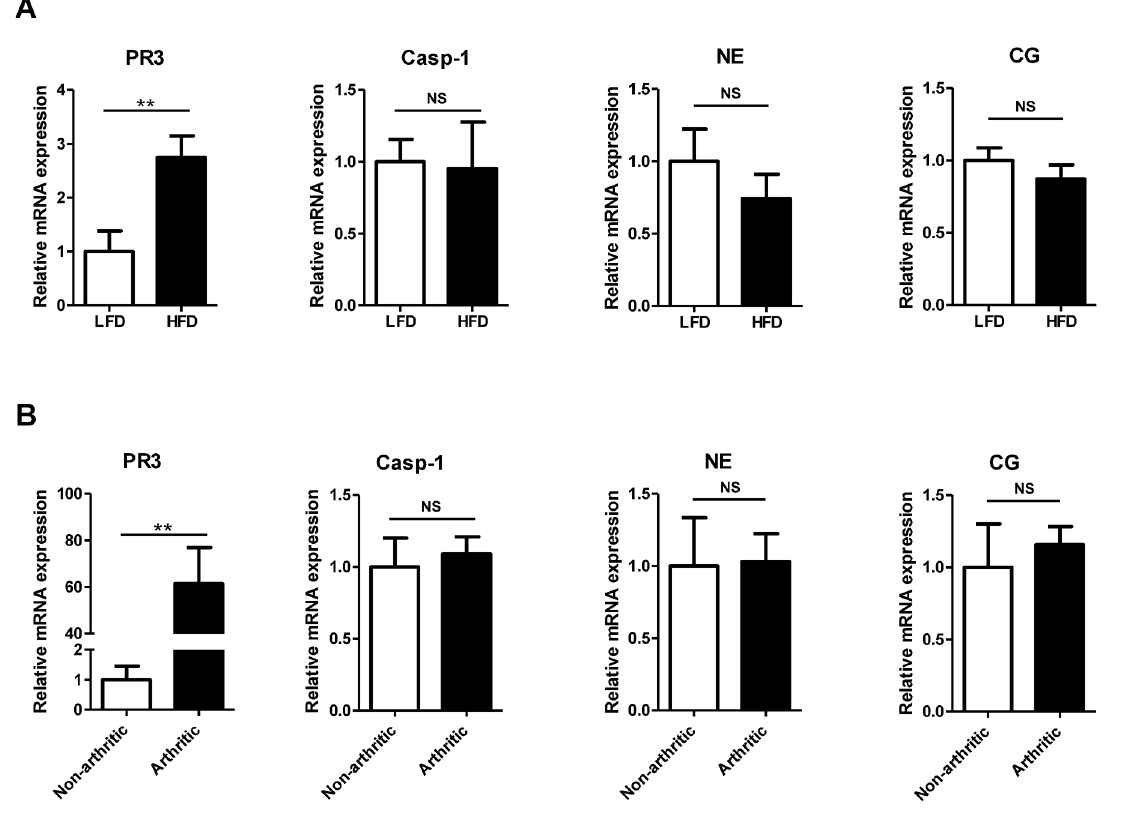
Figure 2. Relative mRNA expression of proteinase 3, caspase-1, neutrophil elastase and cathepsin G in liver. (A) Relative mRNA expres- sion of proteinase 3, caspase-1, neutrophil elastase and cathepsin G after 4 wks of diet intervention. (B) Relative mRNA expression of proteinase 3, caspase-1, neutrophil elastase and cathepsin G in nonarthritic and arthritic mice. PR3, proteinase 3; NE, neutrophil elas- tase; CG, cathepsin G; LFD, low-fat diet; HFD, high-fat diet; **significant difference p ≤ 0.01; NS,